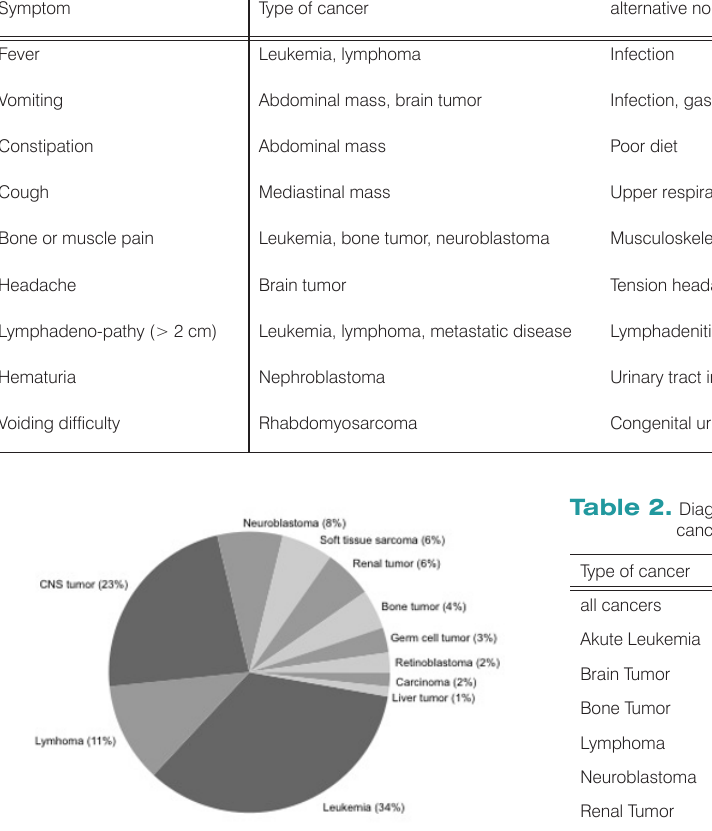
Figure 2. Incidence rates of registered cancer patients aged under 15 years in Germany (1999-2008) [ 2 ]